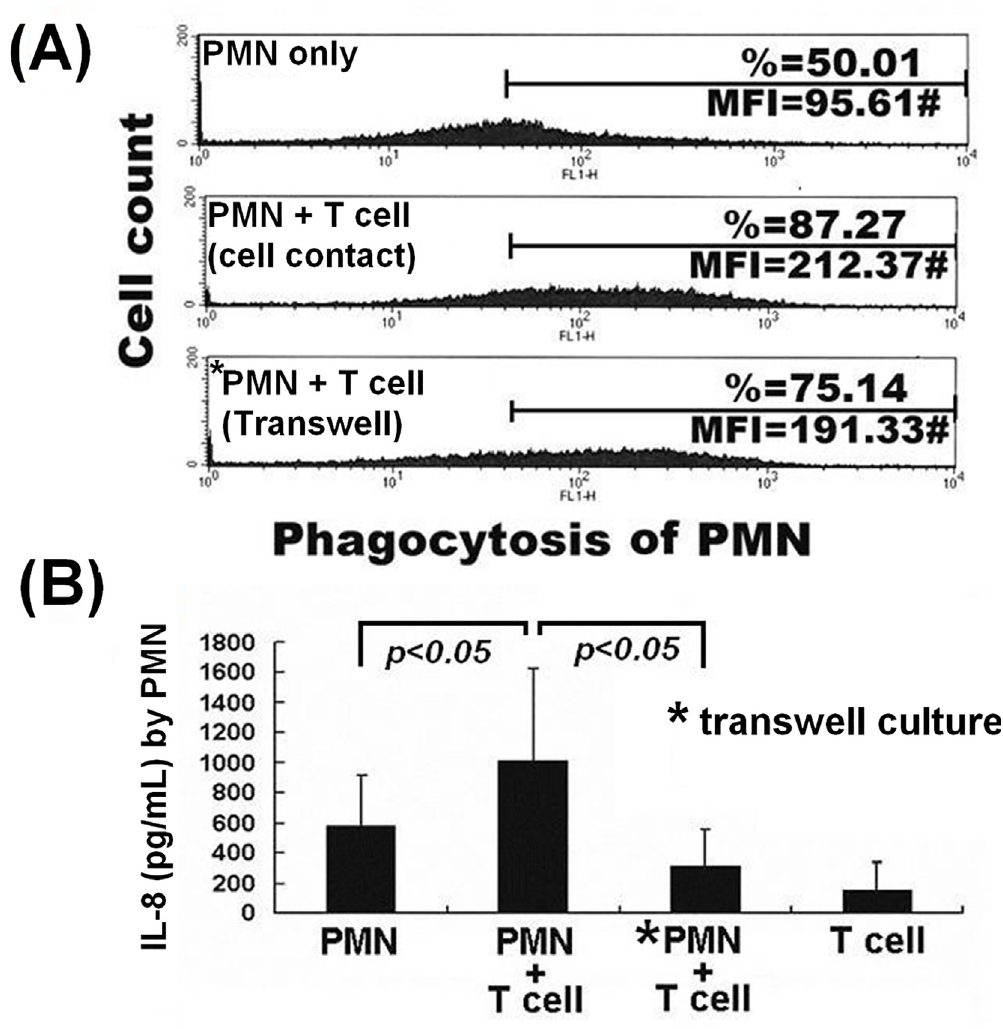
Fig 3. Enhanced phagocytic activity and IL-8 production of PMNs after cell-cell contact with autologous T cells. (A) A representative case from three independent experiments showing PMN phagocytotic activity (%) detected by Flow cytometry. (B) IL-8 concentration (pg/ml) in 6 h co-culture supernatants detected by ELISA (N = 8). * Indicates transwell